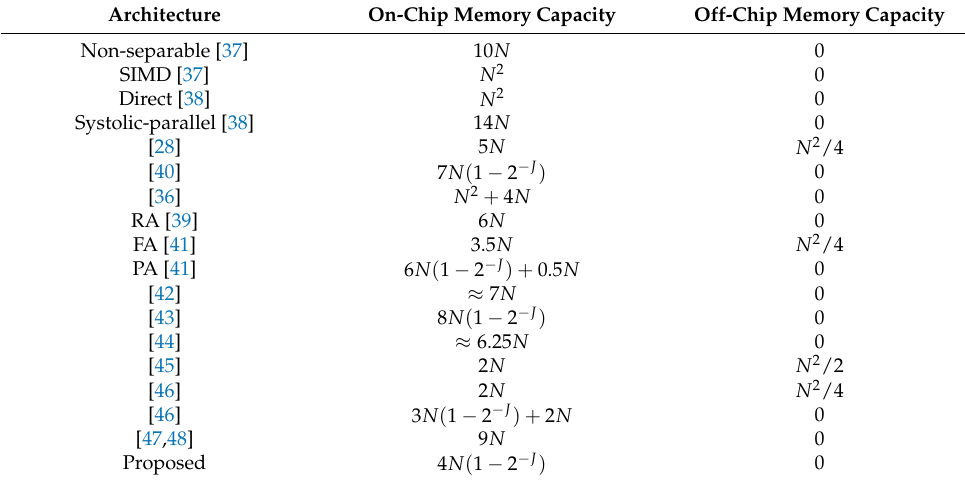
Table 8. Comparison of various 2 ‐ D inverse 5/3 DWT architectures.